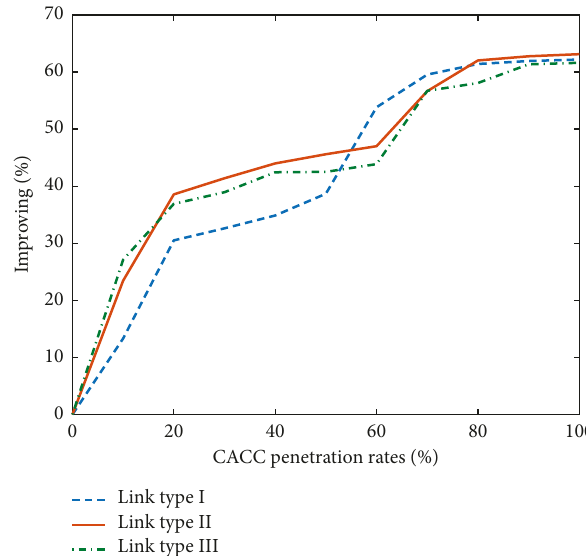
Figure 2: Comparison among CACC link types under 1800veh/hr flow.